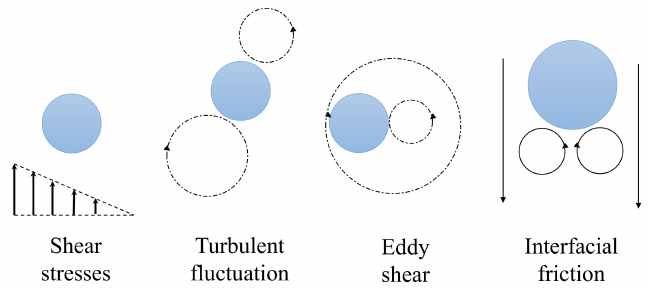
Figure 41. Break-up